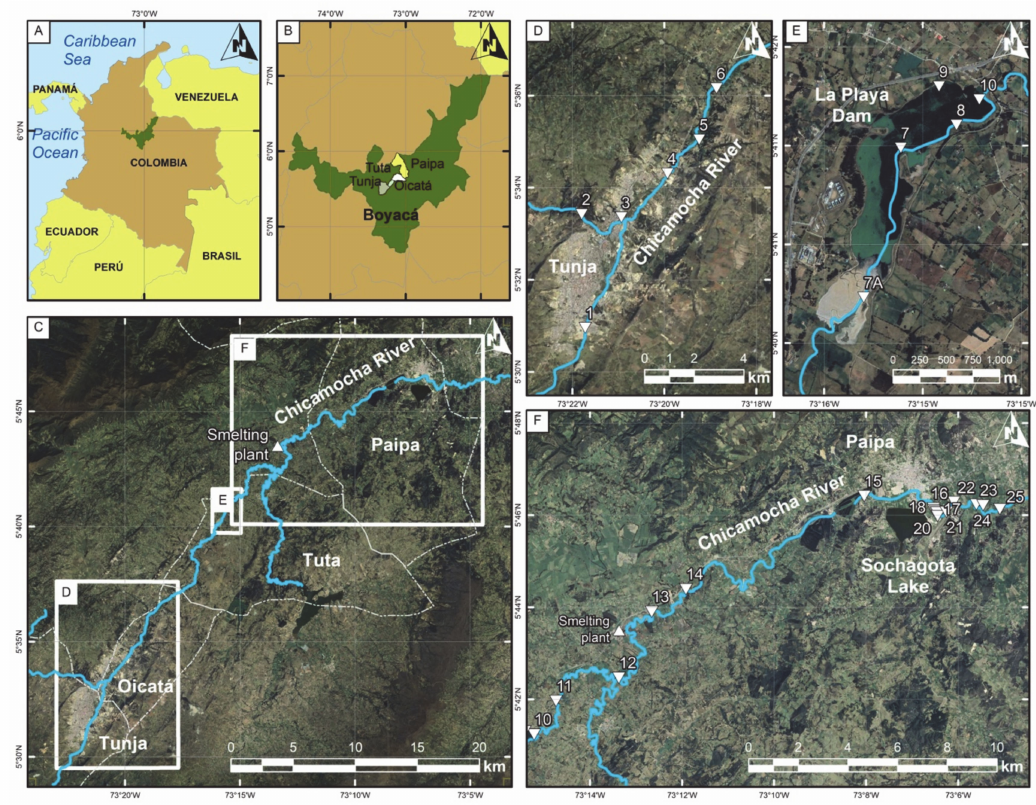
Figure 1. Geographical setting of the study area and sampling location. ( A ) Global context of the area; ( B ) Regional map; ( C ) Studied sector of the Chicamocha River between Tunja and Paipa, Boyac á Province; ( D – F ) Location of the sampling points 1 to